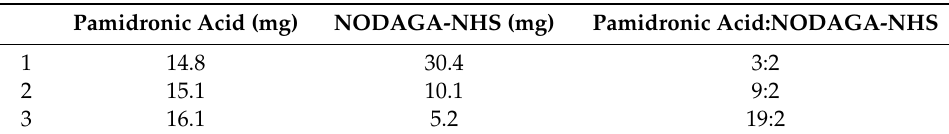
Table 1. Pamidronic acid and NODAGA-NHS molar ratio.